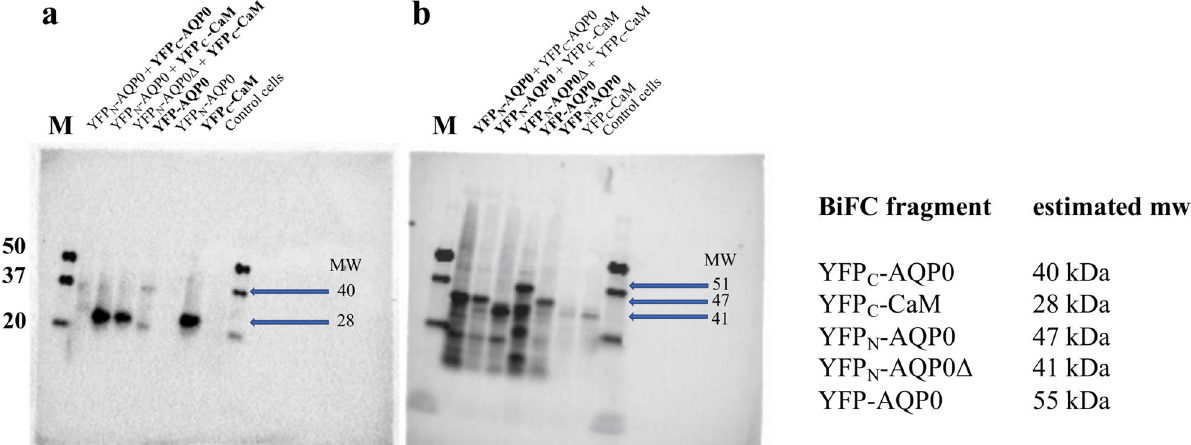
Figure 2. Immunoblot analysis of the various BiFC complexes obtained from cell lysates. Samples were applied in the following order on the blots (a and b): (M) Marker, molecular weight in kDa, (1) YFP N − AQP0 + YFP C − AQP0, (2) YFP N − AQP0 + YFP C − CaM, (3) YFP N − AQP0∆ + YFP C − CaM, (4) YFP − AQP0, (5) YFP N − AQP0, (6) YFP C − CaM, (7) non-transformed S. cerevisiae cells. Monoclonal antibodies against YFP C (a) or YFP N (b) were used. The immunoblot confirms similar expression levels of the BiFC components. The bands corresponding to the BiFC fragments are indicated by arrows with the expected molecular weight and the part of the BiFC complex detected by the antibody is highlighted in